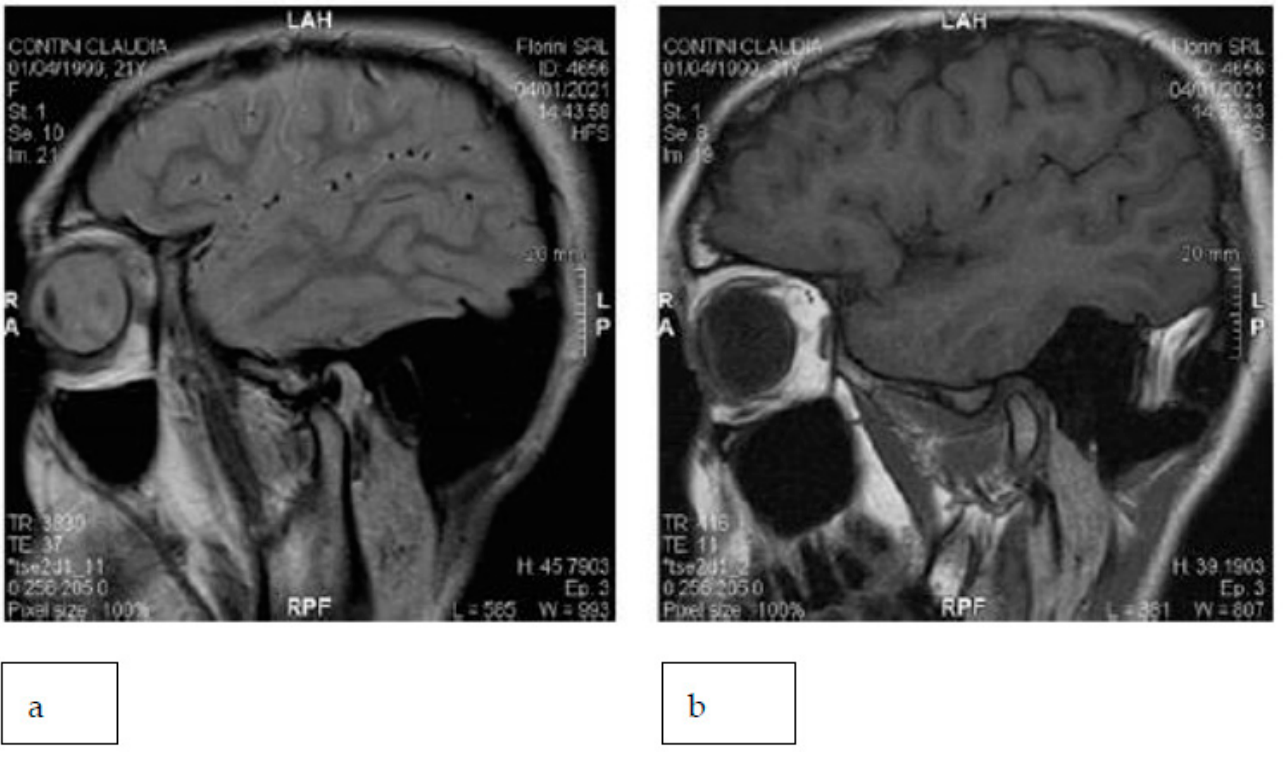
Figure 20. The right TMJ with an open ( a ) and closed ( b ) mouth.